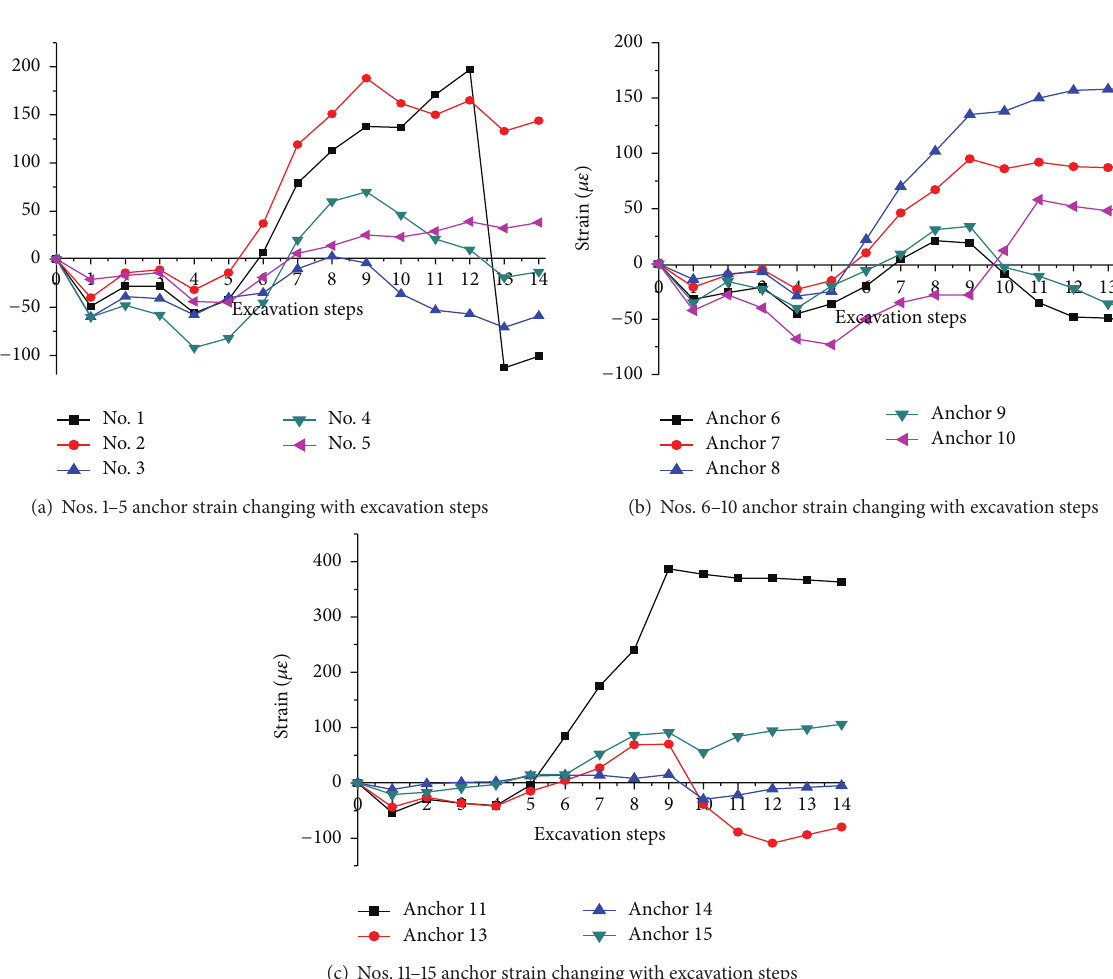
Figure 17: Anchor strain changing with the excavation steps. Note: No. 12 anchor was damaged during the test and the data could not be recorded.